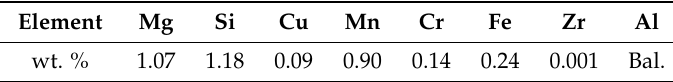
Figure 1. ( a ) Photograph of real body 6082 aluminum forging and ( b ) the diagram of sampling location (all dimensions are in mm). Table 1. Chemical composition of 6082 aluminum alloy.